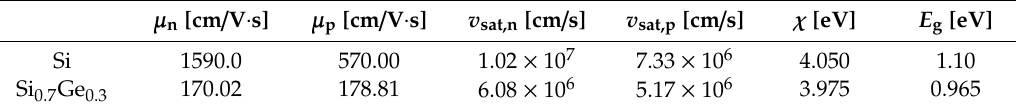
Table 1. Parameters used in this work for Si and